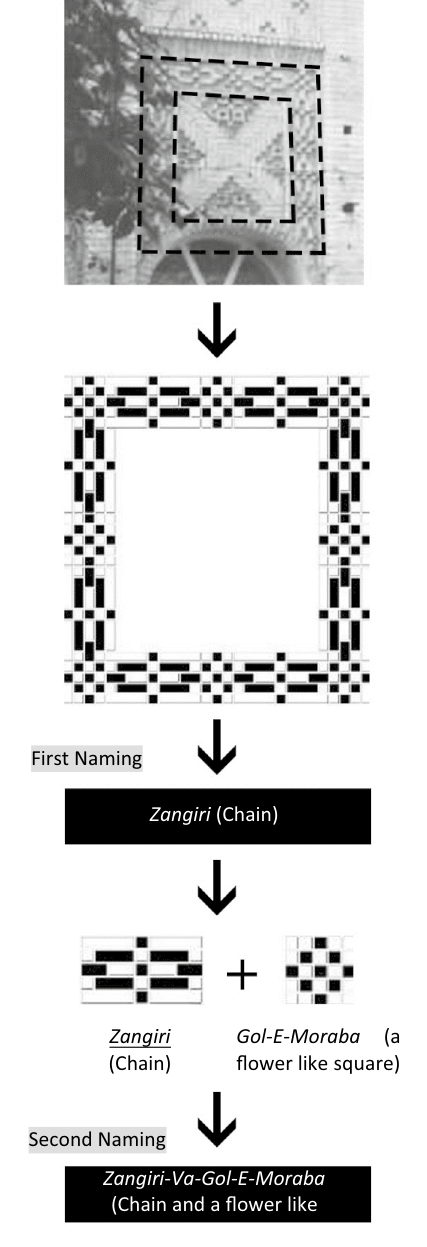
Fig. 6 Naming decorations in a sample (Case study of Zargar house